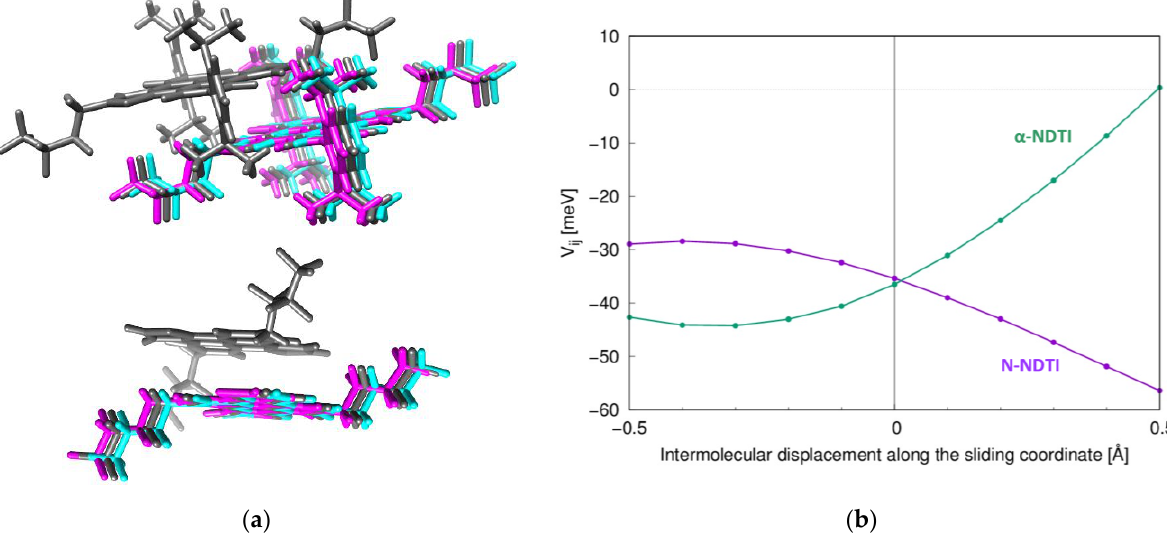
Figure 8. ( a ) Intermolecular sliding motion considered for (top) α-NDTI and (bottom) N-NDTI . Gray molecules represent the crystal structure of the P1 dimer. Cyan and magenta represent displaced molecules along the sliding coordinates. ( b ) Electronic coupling dependence on the sliding coordinates ( α-NDTI in green and N-NDTI in purple).